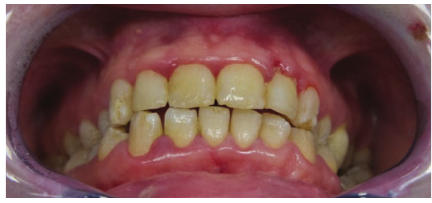
Figure 6: Final result of conservative